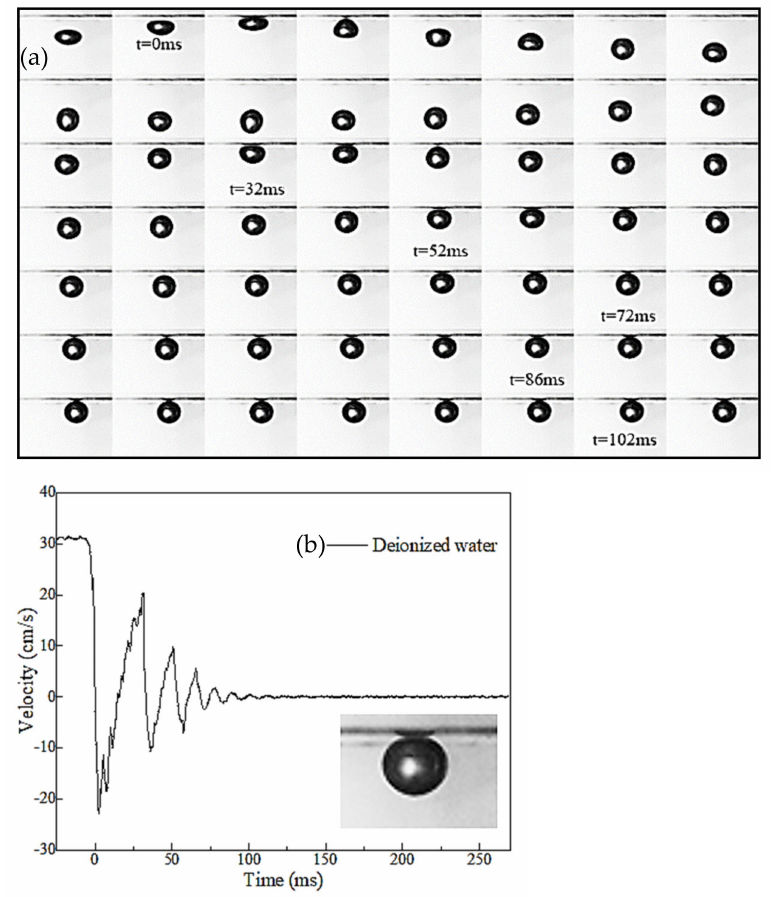
Figure 6. Collision-rebound process ( a ) and velocity variation ( b ) of the bubble with muscovite surface in deionized water.